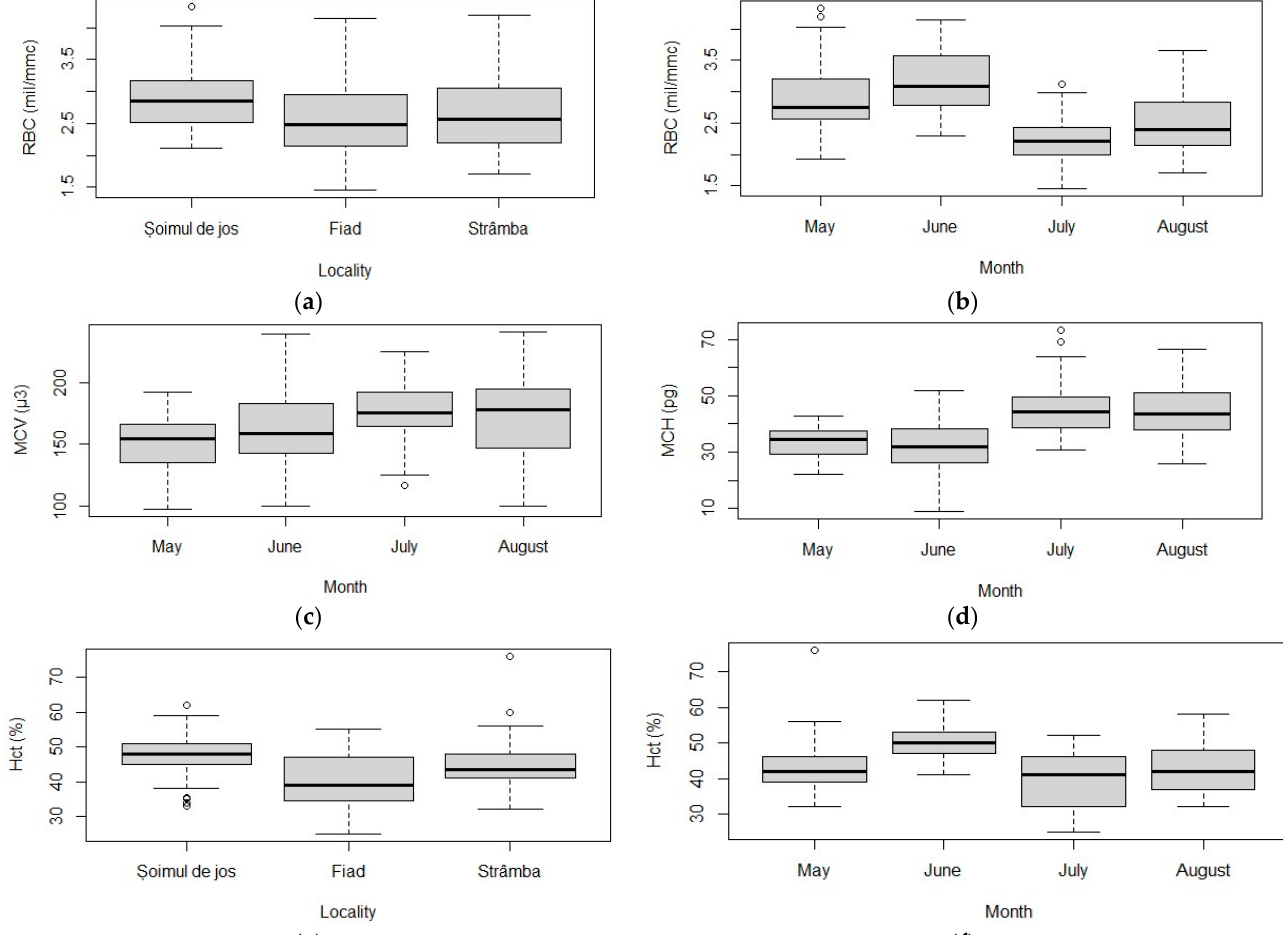
Figure 3. Hematological profile of rainbow trout ( Oncorhynchus mykiss ): ( a ) RBC counts measured in all months in different farms; ( b ) RBC counts measured in all farms in the different months; ( c ) MCV values measured in all farms in different months; ( d ) MCH values measured in all farms in different months; ( e ) Hct values measured in all months in the different farms; ( f ) Hct values measured in all farms in different months. Plots represent median (line inside boxes) values, 25–75 percent quartiles (boxes), and minimal and maximal values, shown with short horizontal lines (“whiskers”). Outliers are represented with an open circle sign.